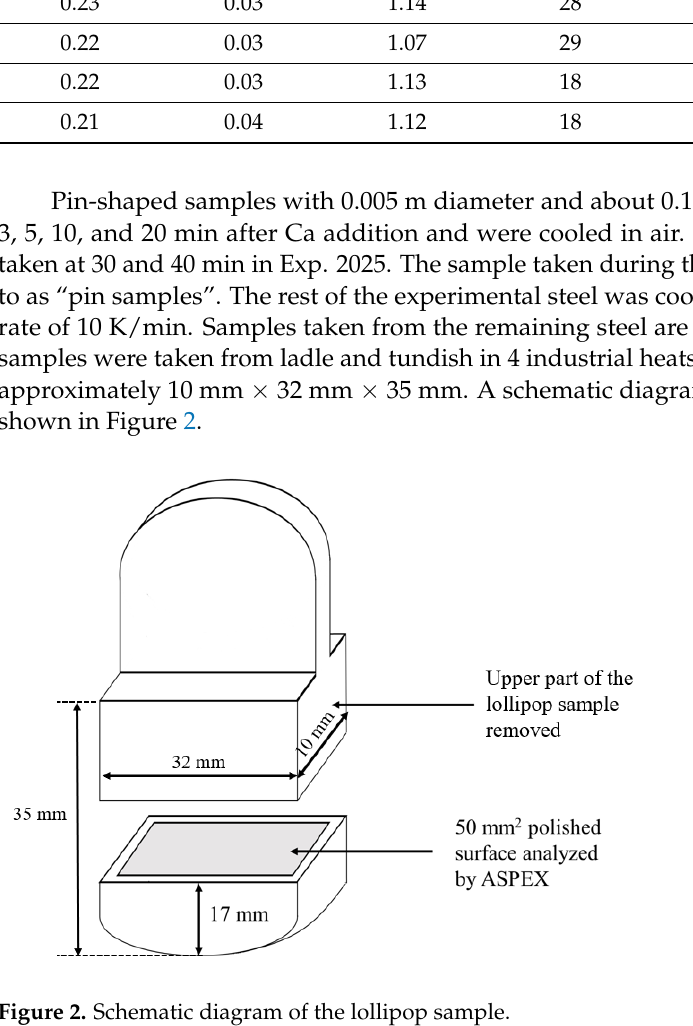
Figure 2. Schematic diagram of the lollipop sample.